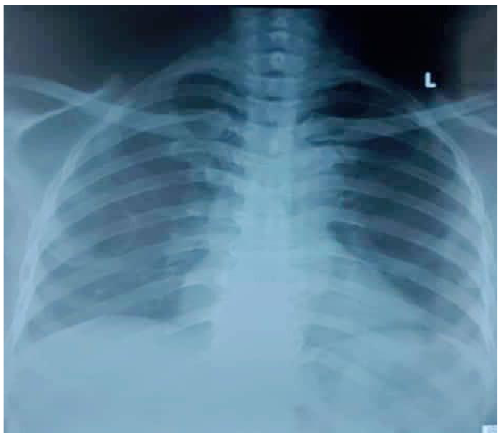
Figure 1. Opacities in the right lung fields and hilar fullness